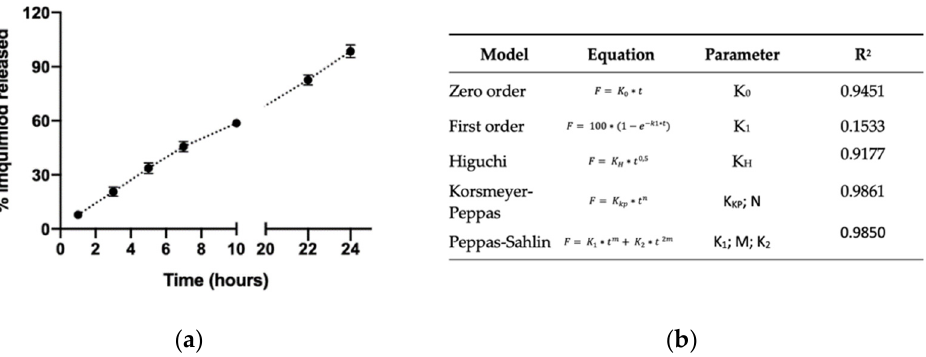
Figure 3. ( a ) Profile of imiquimod released from dextran nanocapsules with imiquimod in their core in acetate buffer pH = 5.5 at 37 °C for 24 h ( b ) Release model studies for the delivery of imiquimod from the dextran nanocapsules (Mean ± SD, n = 3).